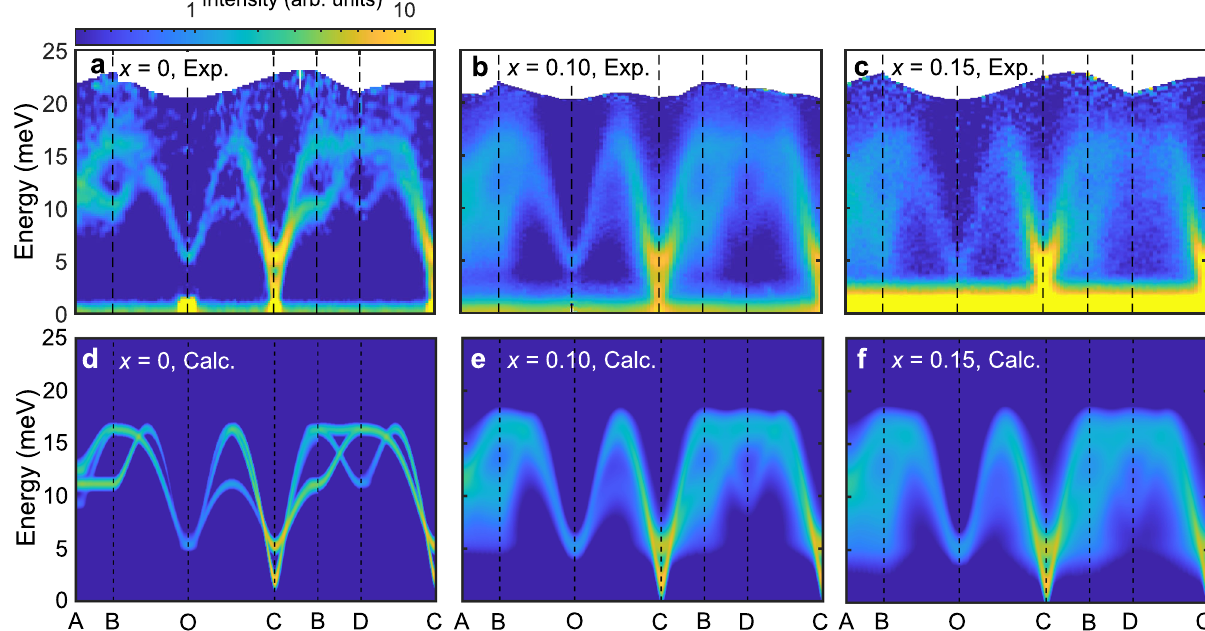
Fig. 2 Magnetic excitation spectra of h -YMn 1- x Al x O 3 . a – c INS spectra of a h- YMnO 3 (ISIS), b h- YMn 0.9 Al 0.1 O 3 (J-PARC) and c h- YMn 0.85 Al 0.15 O 3 (J-PARC) measured at 5 K with the incident neutron energy of E i = 30 meV. The scattering intensity of the data was integrated over the c ∗ -axis. d – f Theoretical INS cross-section of d h- YMnO 3 , e h- YMn 0.9 Al 0.1 O 3 , and f h- YMn 0.85 Al 0.15 O 3 , which include the instrumental resolution convolution as well as the data integration effect over the c ∗ -axis (see